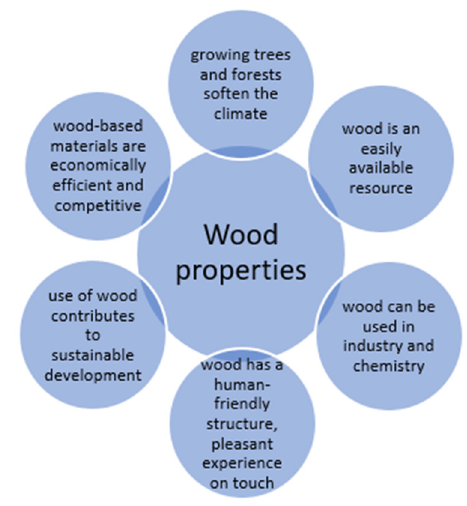
Figure 1. Wood properties. Source: own.